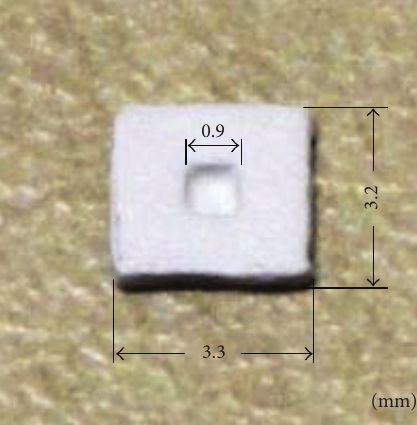
Figure 3: A MEMS component with a thickness of 0.55 mm. The surface was treated with diffusive paint.